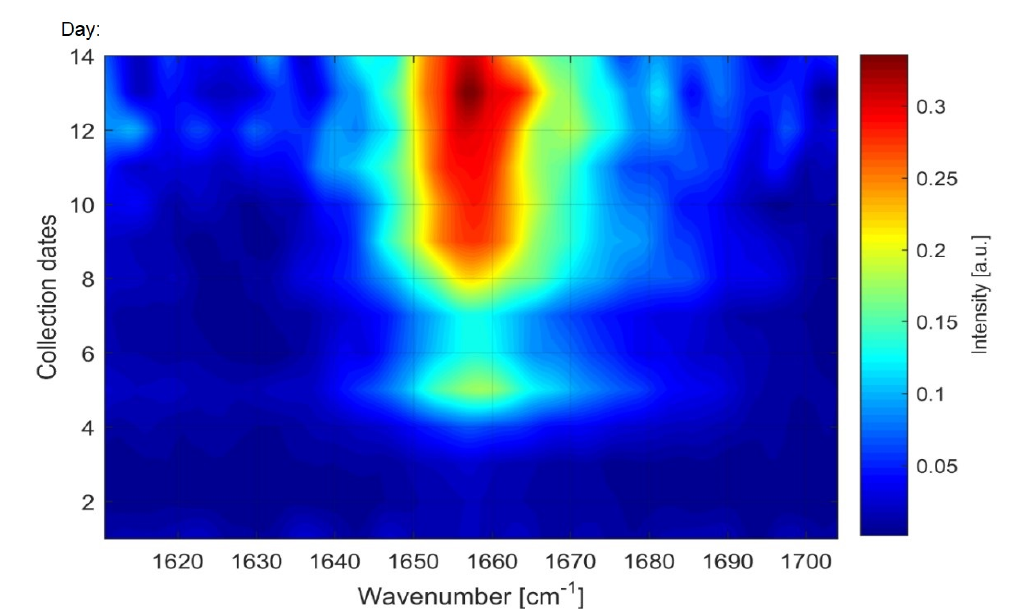
Figure 8. Spectral map plotted using Raman line intensities for unsaturated oil for 14 collection dates (days of cultivation). The map qualitatively monitors unsaturated oil within the cells ( Metschnikowia andauensis 129) at different collection dates. Higher intensity refers to higher levels of unsaturation.